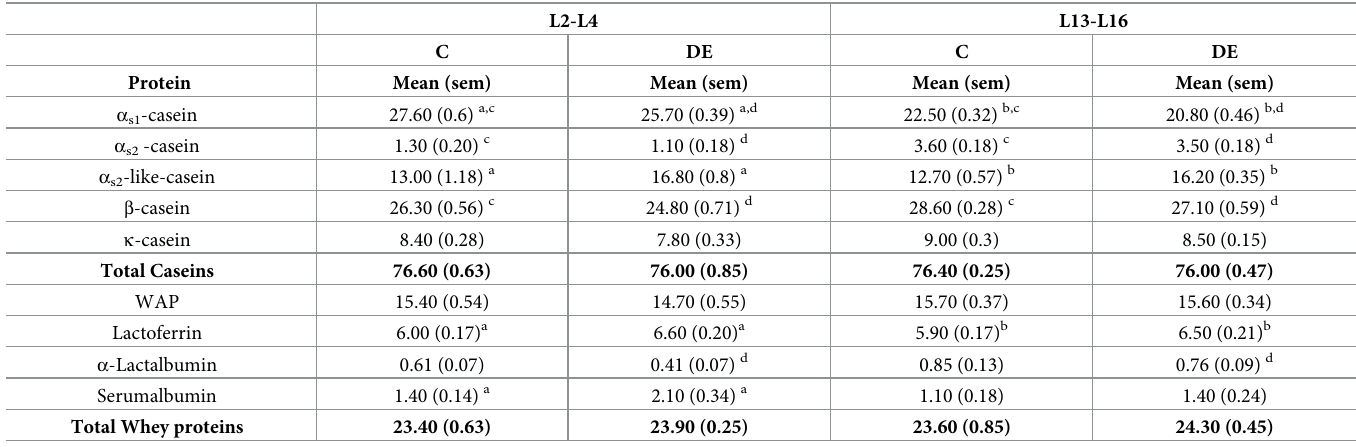
Table 3. Quantitative analysis of major milk proteins.